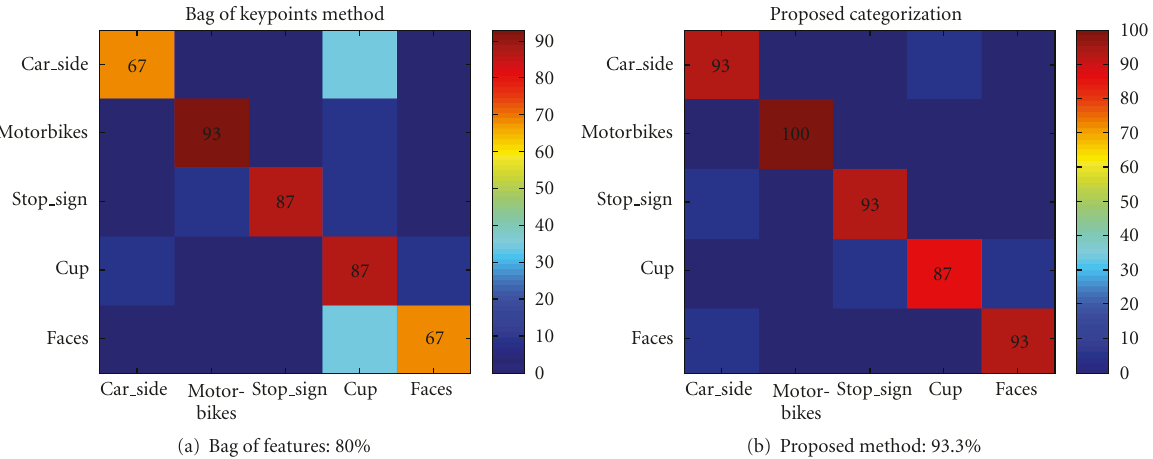
Figure 30: The improvement of categorization.